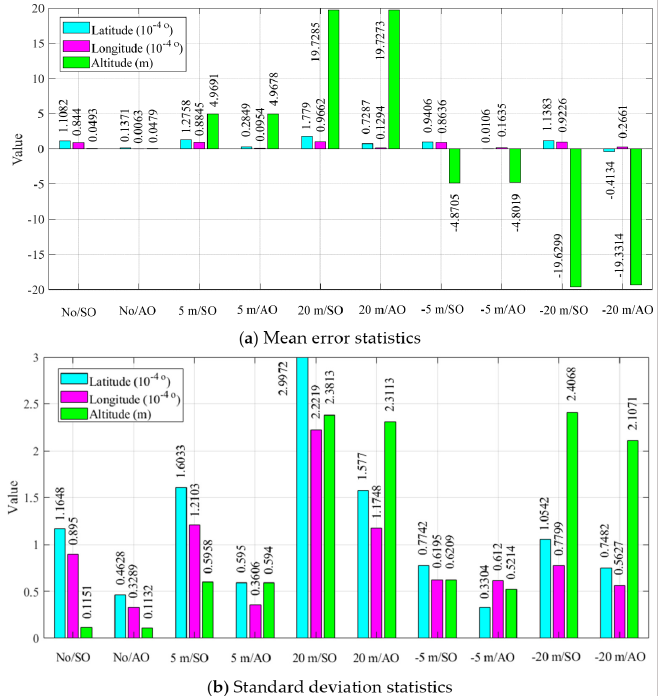
Figure 10. Navigation and positioning error statistics of different altimeter deviations under a fixed switching time of 5